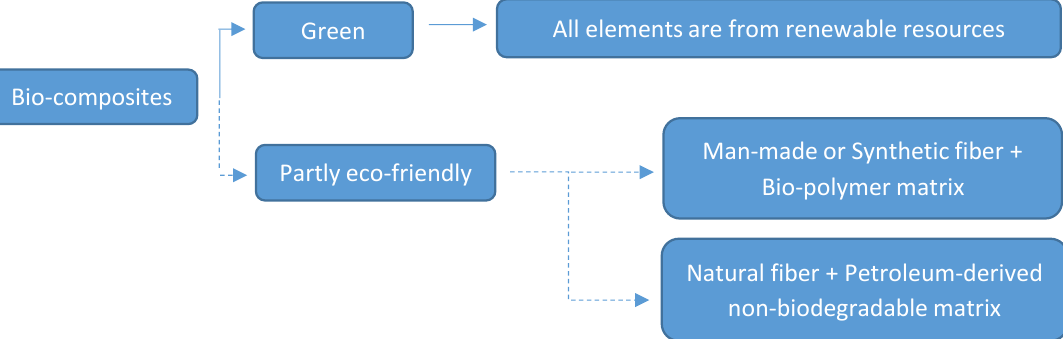
Figure 1. Classification of bio-composites. Adapted from: [1 – 3].